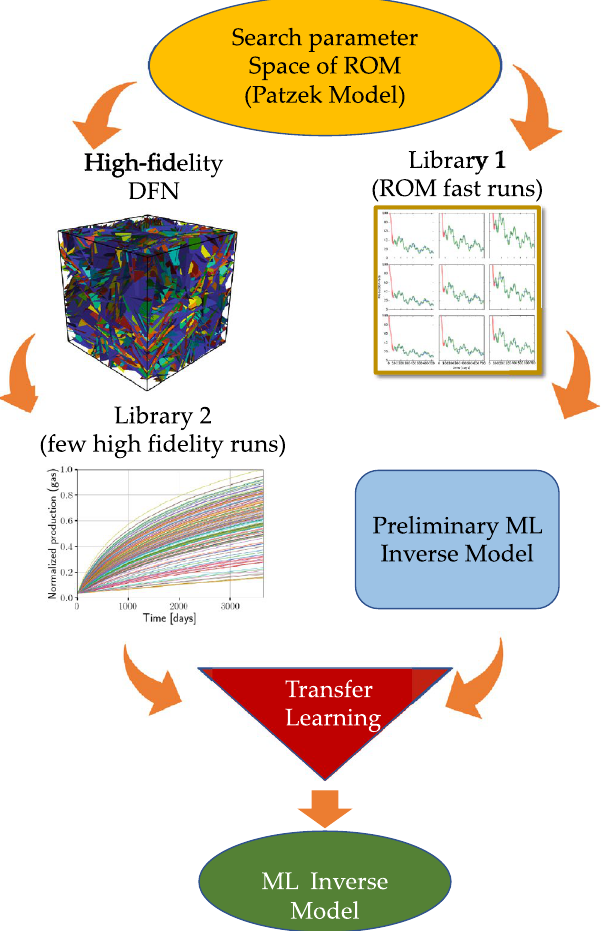
Figure 2. A magnified look at the steps to produce an ML inverse model illustrating how the transfer learning paradigm uses both synthetic data from reduced-order models as well as high-fidelity models. Note that in this workflow, we used Patzek model as the reduced-order model, but the same workflow can be used with other reduced-order model choices that may be physics-based or even